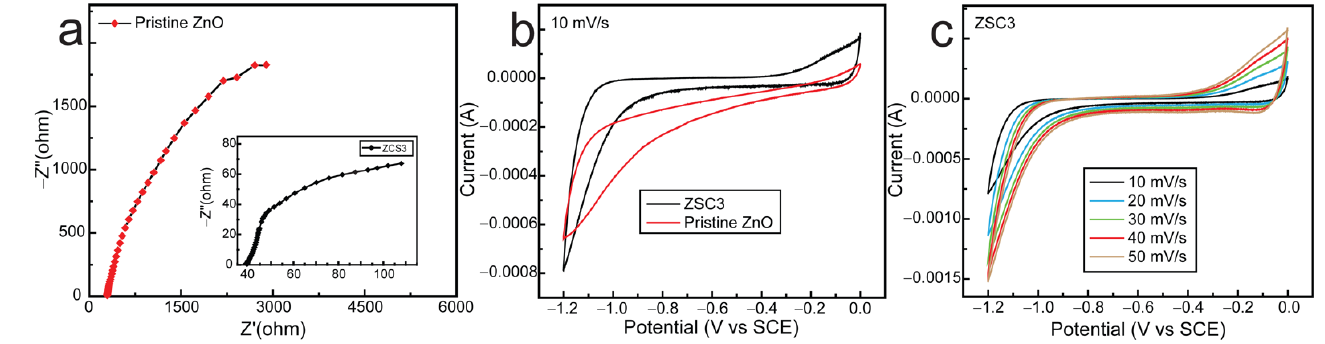
Figure 8. ( a ) EIS of pristine ZnO and ZSC3, ( b ) CV curves for ZSC3 and pristine ZnO, ( c ) CV curves of ZSC3 at different scan rates.